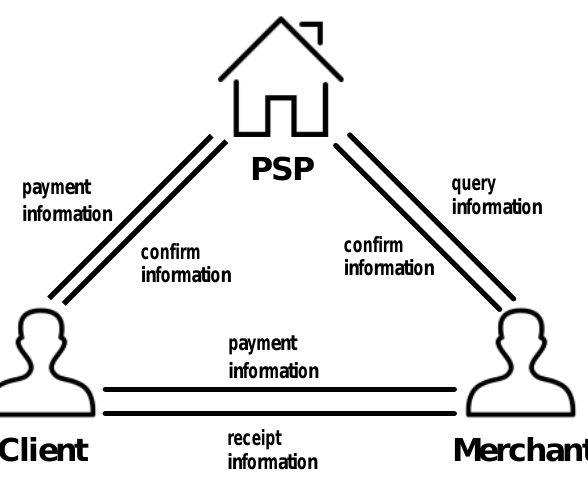
Figure 1. System